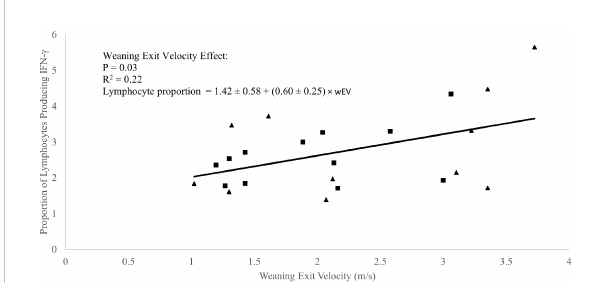
FIGURE 4 Regression of the proportion of lymphocytes producing interferon- g against weaning exit velocity (wEV) during two experiments utilizing heifer calves. Experiment 1 (n = 12 heifers) data is a three-week baseline average of the proportion of lymphocytes producing interferon- g beginning one week after calves were placed in barn. Experiment 2 (n = 11 heifers) data were from a single collection on the day calves were placed in the barn. One data point was removed from experiment 2 data due to an insuf fi cient number of cells harvested from the sample. PBMCs were isolated from whole blood collected weekly via jugular venipuncture, treated with transport inhibitor brefeldin A, and stimulated with phorbol 12-myristate 13-acetate + ionomycin. Experiment 1 ( ■ ). Experiment 2 ( ▲ ). Experiment was not a signi fi cant source of variation (P = 0.98), and there was no interaction between experiment and wEV (P = 0.87).